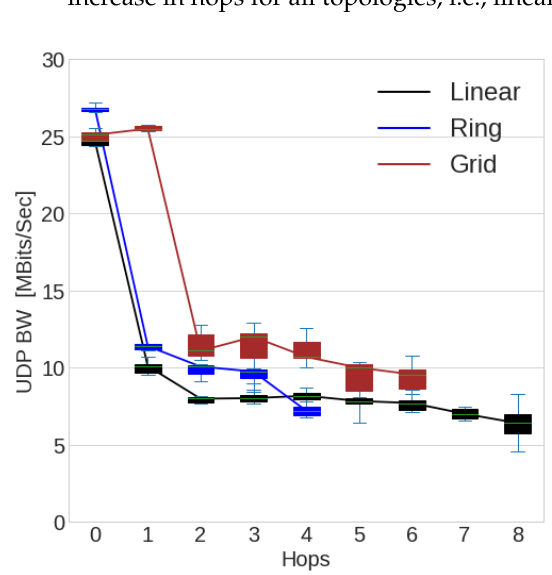
Figure 19. W-iLab1.t UDP bandwidth.